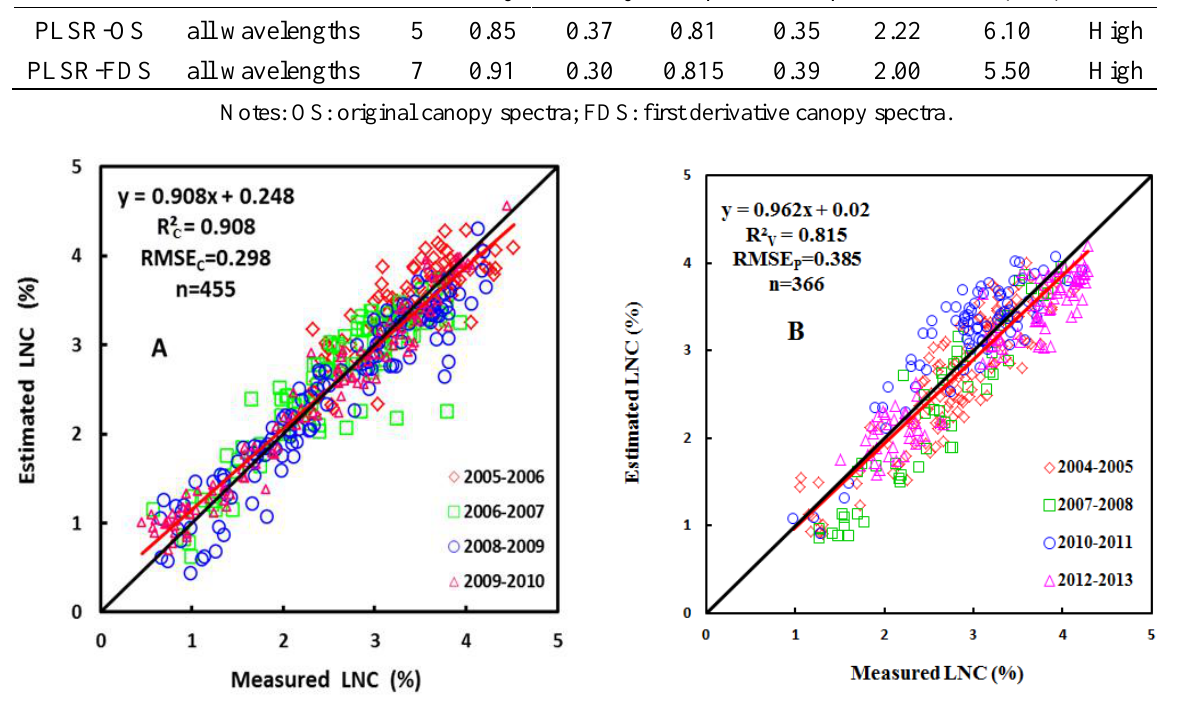
Figure 7. The 1:1 relationship between the measured LNC and those estimated values using the PLSR analysis on the first derivative canopy spectra (PLSR-FDS) model for the calibration ( A ) and validation ( B )